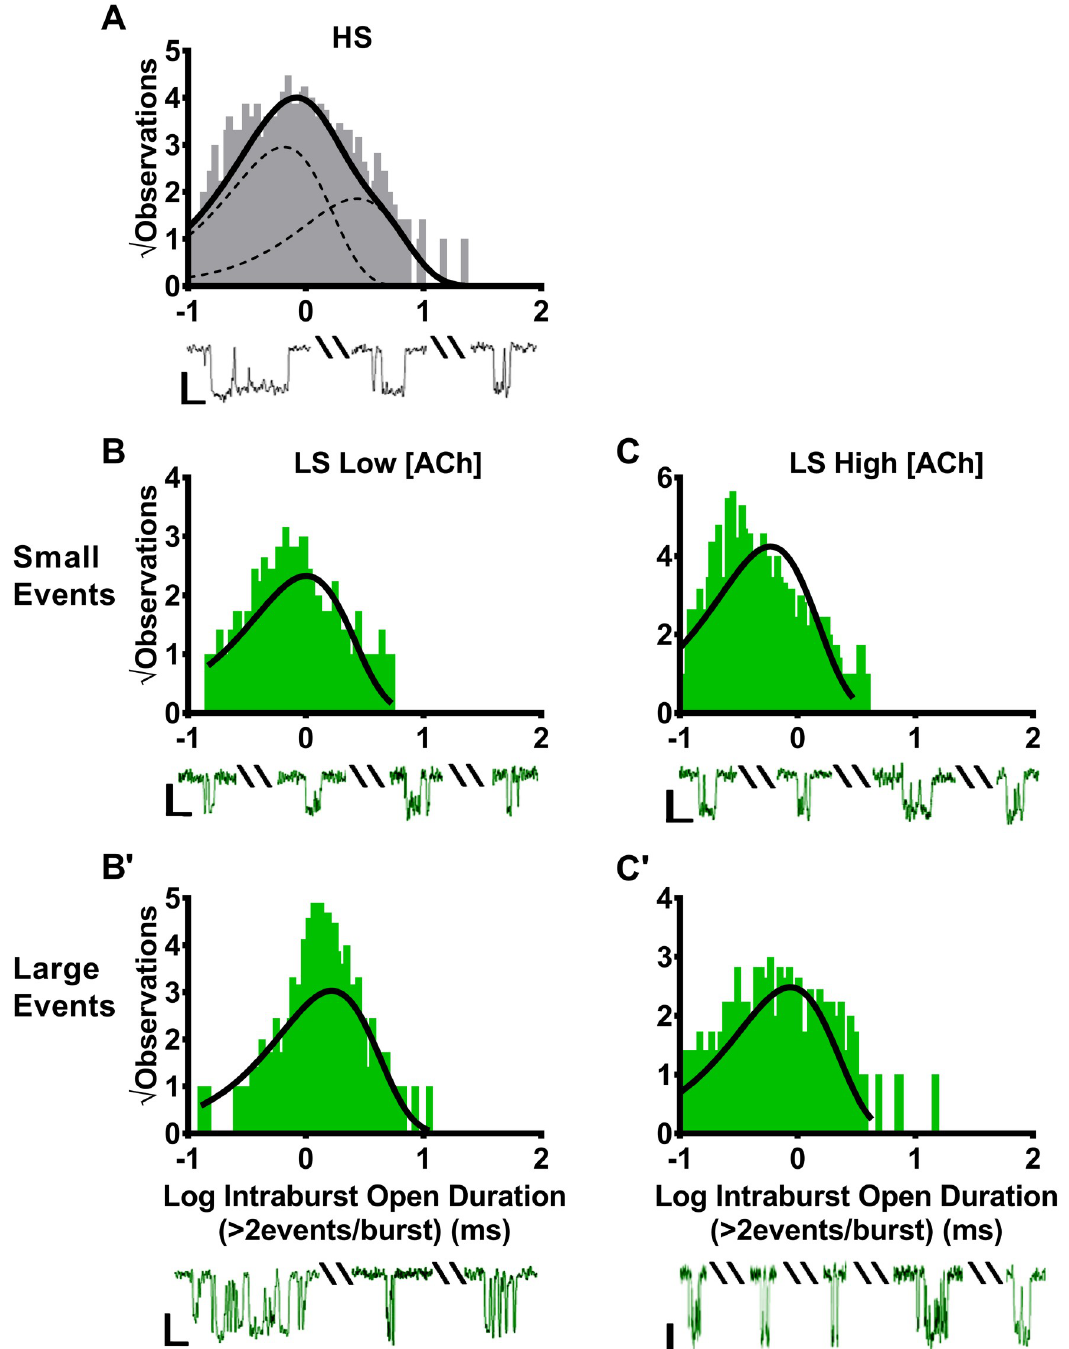
Fig 7. Durations of individual openings within bursts of small and large amplitude openings of human HS or LS α 4 β 2-nAChR isoforms. HS or LS isoforms were expressed in X . laevis oocytes using unlinked subunits, and durations of individual openings within bursts (intraburst) of activity were measured. (A) HS ( α 4 β 2) 2 β 2-nAChR stimulated with 1.3 μ M ACh exhibited intraburst openings with a single, small, characteristic amplitude, as described previously. The open dwell durations associated with these openings were best described using a pair of time constants. For LS ( α 4 β 2) 2 α 4-nAChR stimulated with a low ACh concentration (0.7 μ M), bursts of either small (B) or large amplitude (B’) events were seen. Further, each type of burst was associated with a single, characteristic, intraburst duration of individual openings. The open durations for individual events within small amplitude bursts were significantly shorter than those associated with individual events within large amplitude bursts. When the ACh concentration was increased to 30 μ M, the same general outcome was found. Intraburst open durations of individual openings of